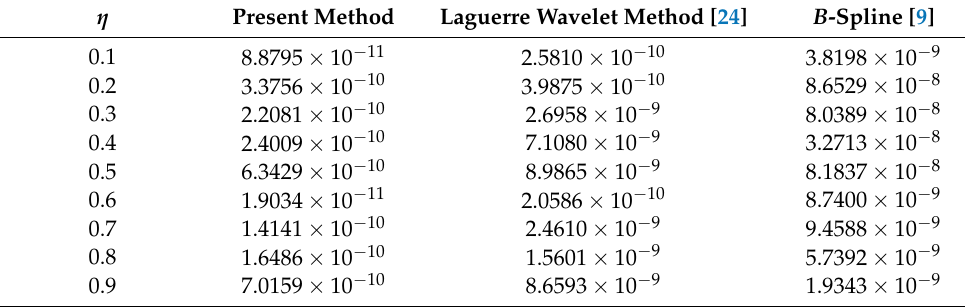
Table 5. Comparison of the proposed method’s absolute error with the HWM and B -spline methods of Example 2 for ζ =